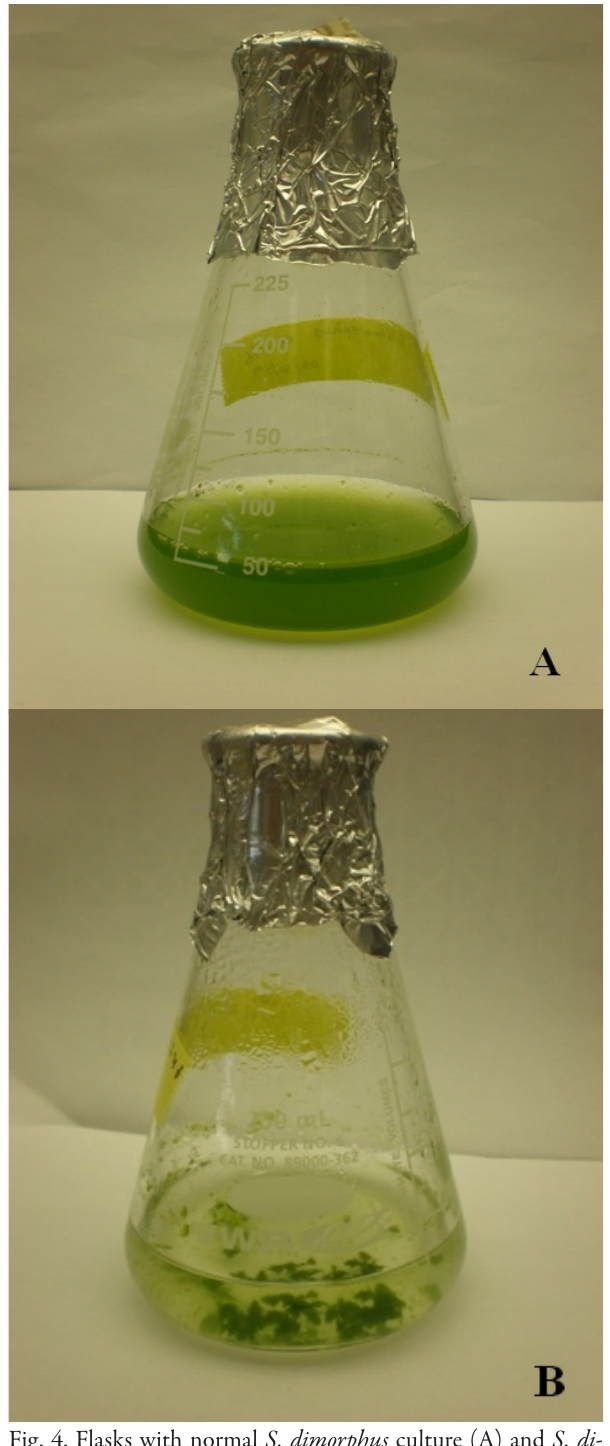
Fig. 4. Flasks with normal S. dimorphus culture (A) and S. di-